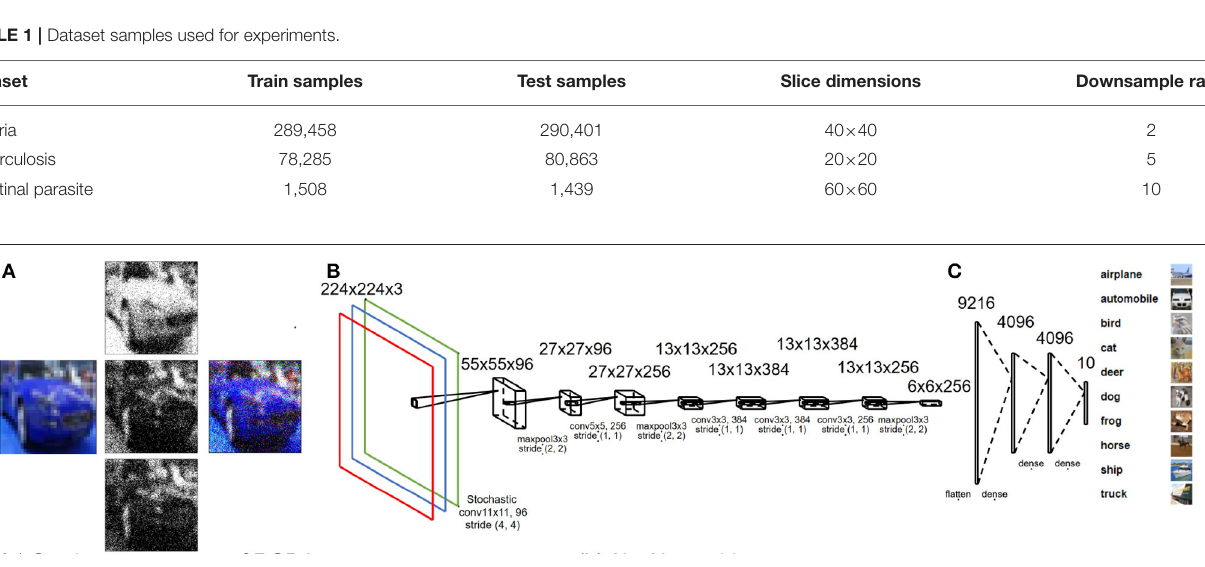
FIGURE 2 | (A) Stochastic sampling for multi-channel input images based on normal distribution. (B) Modified AlexNet architecture used for CIFAR-10-based case study. (C) CIFAR-10 dataset samples for each class.